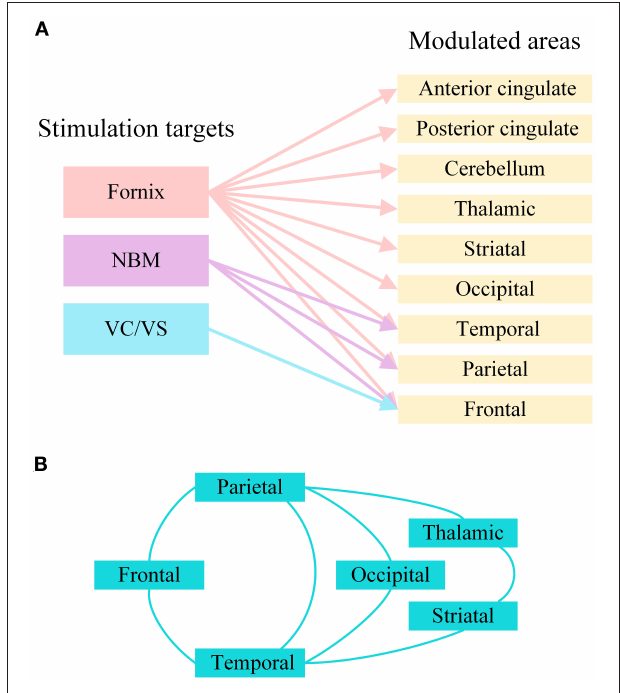
FIGURE 3 | The modulated brain structure of AD patients after DBS in the current study. (A) Modulated brain areas of AD patients after DBS of different targets. (B) Modulated brain networks of AD patients after DBS. NBM, nucleus basalis of Meynert; VC/VS, ventral capsule/ventral